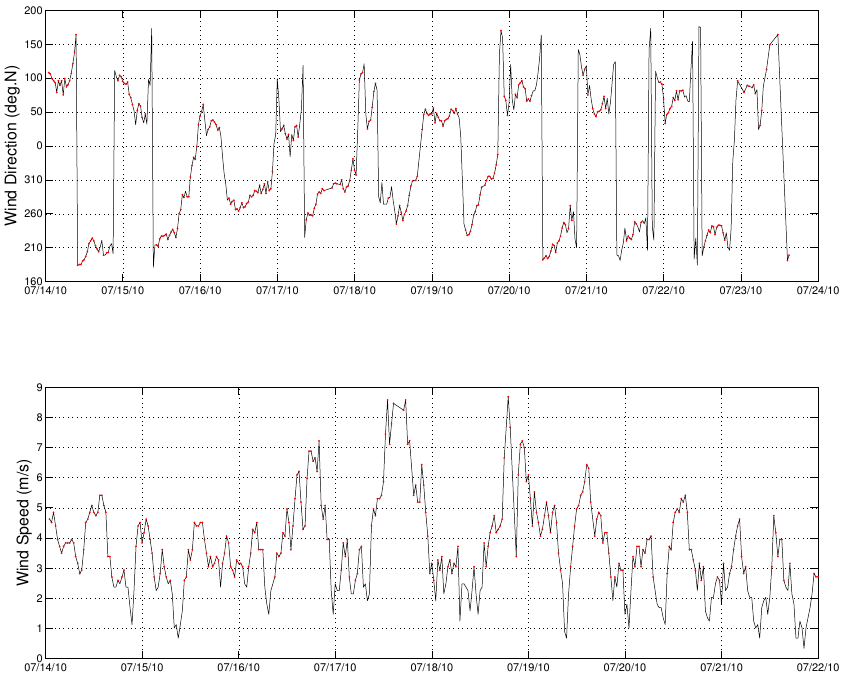
Fig. 8a. 14 July 2010, salinity at –5 m. Fig. 7. Offshore wind recorded at the RON buoy of Civitavecchia 14–24 July. Upper panel: wind direction; Lower panel: wind speed. Red dots indicate wind speed greater than 2.5 m s − 1 .